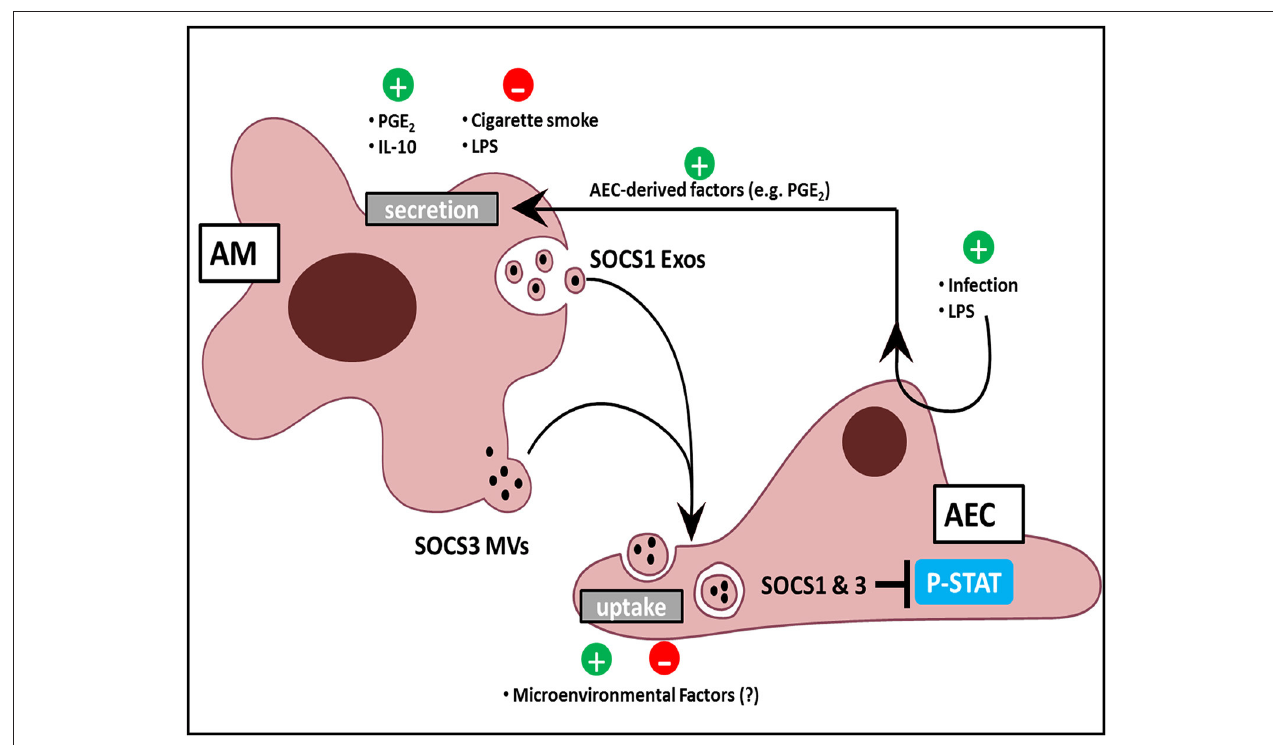
FIGURE 2 | AM and AEC crosstalk in the lung. AMs release Exos and MVs containing SOCS1 and SOCS3, respectively. Positive regulators of SOCS release include the bioactive lipid PGE 2 , the cytokine IL-10, and AEC-derived mediators in response to LPS and infection. Negative regulators include acute, direct AM exposure of LPS, and cigarette smoke. AEC uptake of SOCS-containing EVs might likewise be modulated by constituents of the normal alveolar milieu or by exogenous factors to which the lung is exposed. Additionally, EV uptake by AECs results in inhibition of cytokine-induced STAT